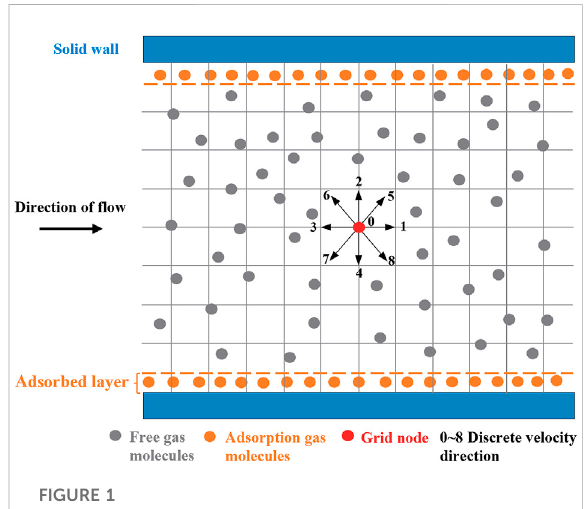
FIGURE 1 Physical model of gas transport in coal